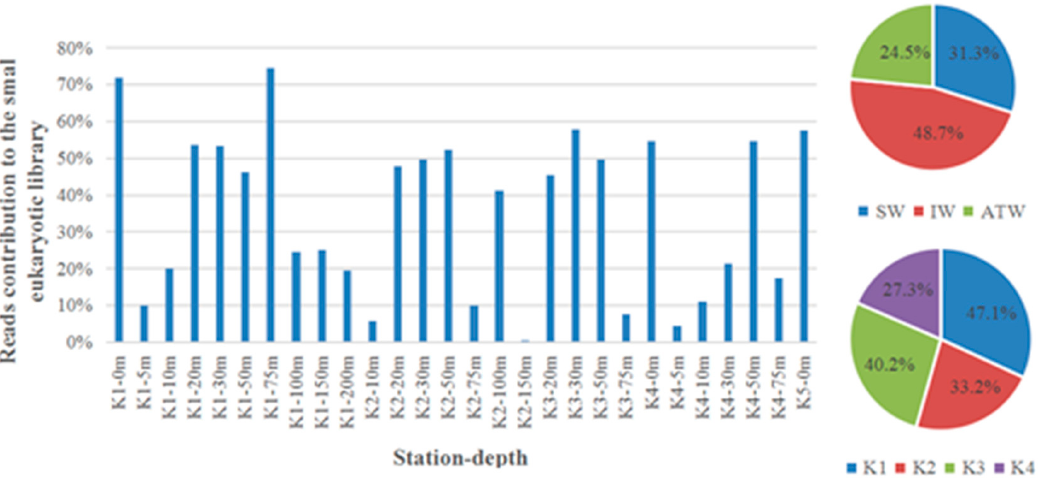
Figure 6. Contributions of Poterioochromonas malhamensis to microeukaryotic DNA library from different water masses and water-layers at different stations in the Kongsfjorden. SW = surface water; IW = intermediate mixed water; TAW = Transformed Atlantic water [31].